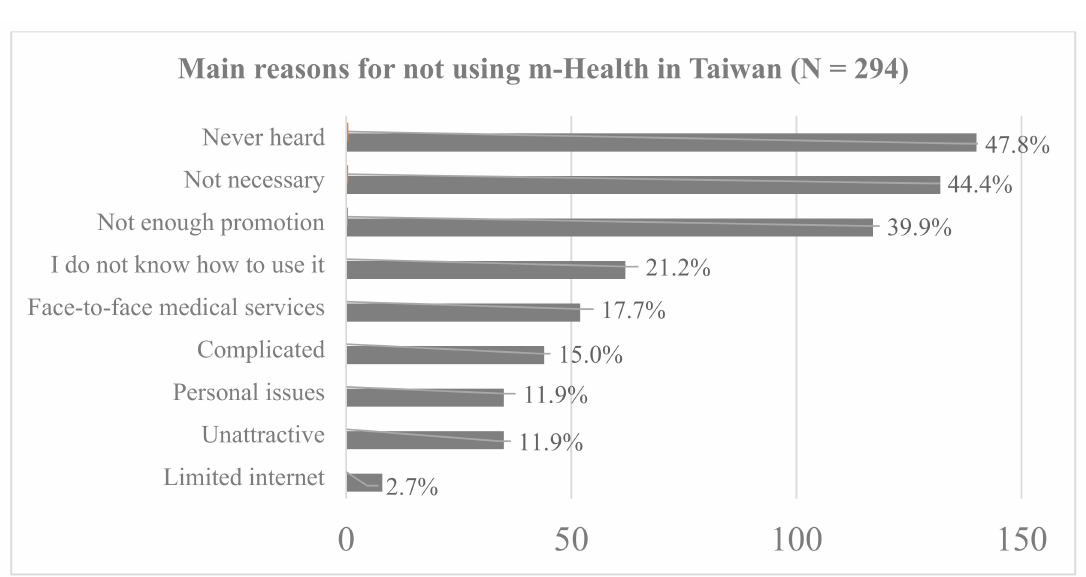
Figure A2. The reasons why people do not use m-Health in